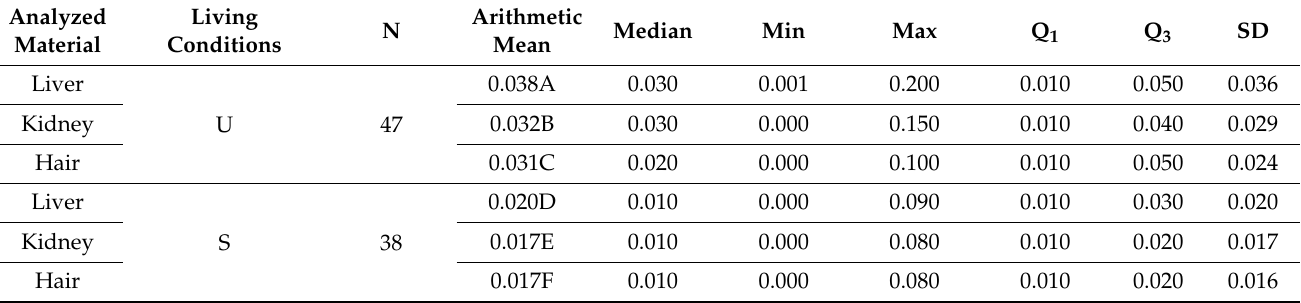
Table 6. Mercury contents depending on living conditions in milligrams per kilogram.